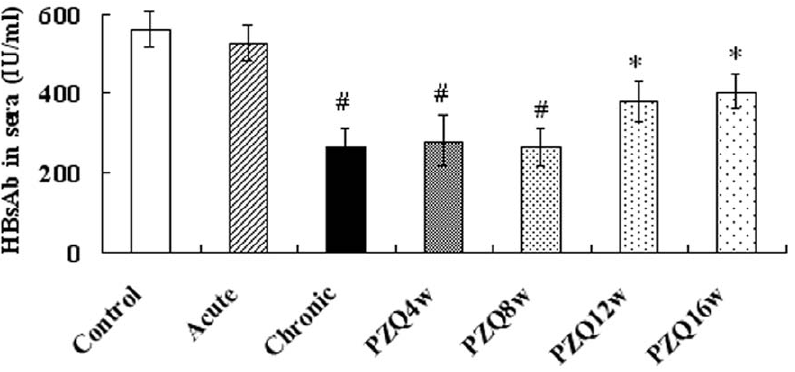
Figure 1. Levels of anti-HBsAg antibody in sera of mice. Anti-HBsAg antibody was individually determined by a commercial enzyme-linked immunoassay. Two separate experiments (n=10 mice/group) were performed and the data from two independent experiments were pooled and so each value shown represents the means and SE of 20 value. * P , 0.05 versus control group. # P , 0.01 versus control group.